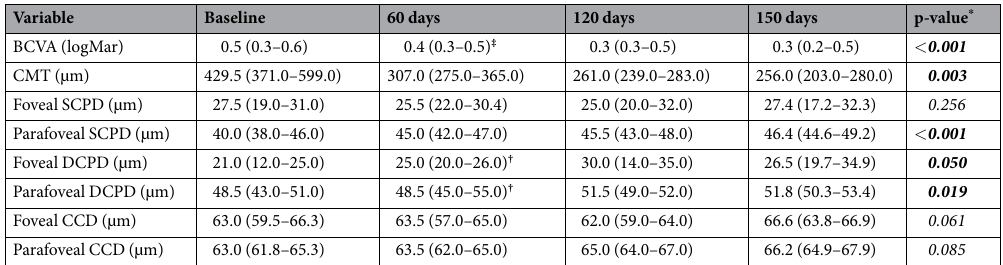
Table 2. Anatomical and functional parameters during the follow-up. * Friedman test evaluating variation in anatomical and functional parameter among time; † p < 0.05, ‡ p < 0.001 pairwise post-hoc analysis vsprevious measurement. Bolded p-value were significant after FDR correction. Abbreviations: BCVA = best corrected visual acuity, CMT = central macular thickness; SCPD = superior capillary plexus density; DCPD = deep capillary plexus density; CCD = choriocapillaris